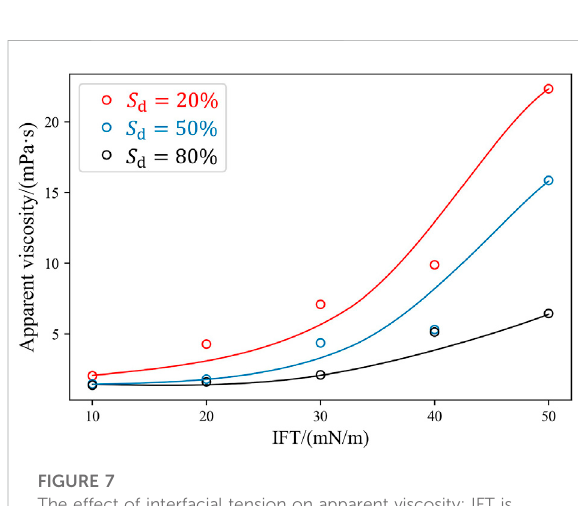
FIGURE 7 The effect of interfacial tension on apparent viscosity: IFT is the interfacial tension.